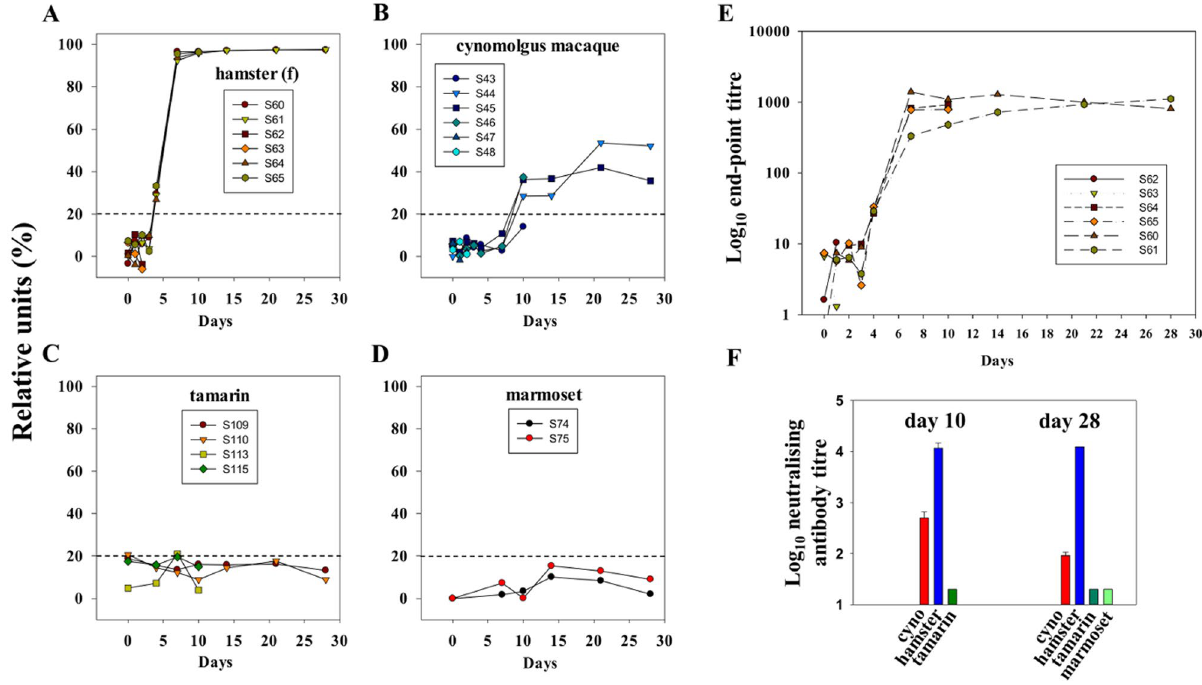
Figure 8. Time-course of anti-SARS-CoV-2 responses across species. Anti-RBD antibodies detected by the Genscript surrogate competition ACE-2 neutralisation (C-ACE-2) assay expressed as percentage inhibition (relative units) for ( A ) female hamsters, ( B ) cynomolgus macaque, ( C ) tamarin, ( D ) marmoset 0-28dpi. Dotted lines indicate assay cut-off of specific reactivity. ( E ) Log 10 end-point titers measured in hamster sera by C-ACE-2 assay, ( F ) titres by microneutralisation assay (MNA) 10 and 28 days post-infection for hamsters (blue), cynomolgus macaques (red), tamarins (dark green) and for marmosets at day 28 (light